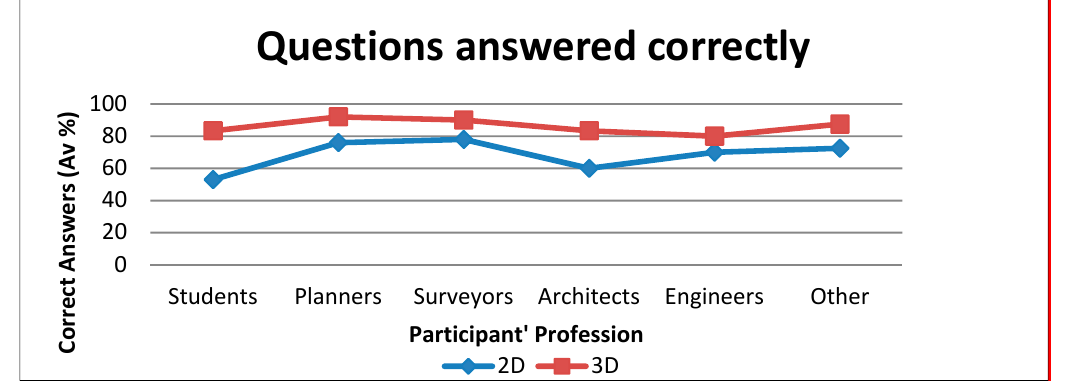
Figure 4. The percentage of correct answers categorized per profession (effectiveness).